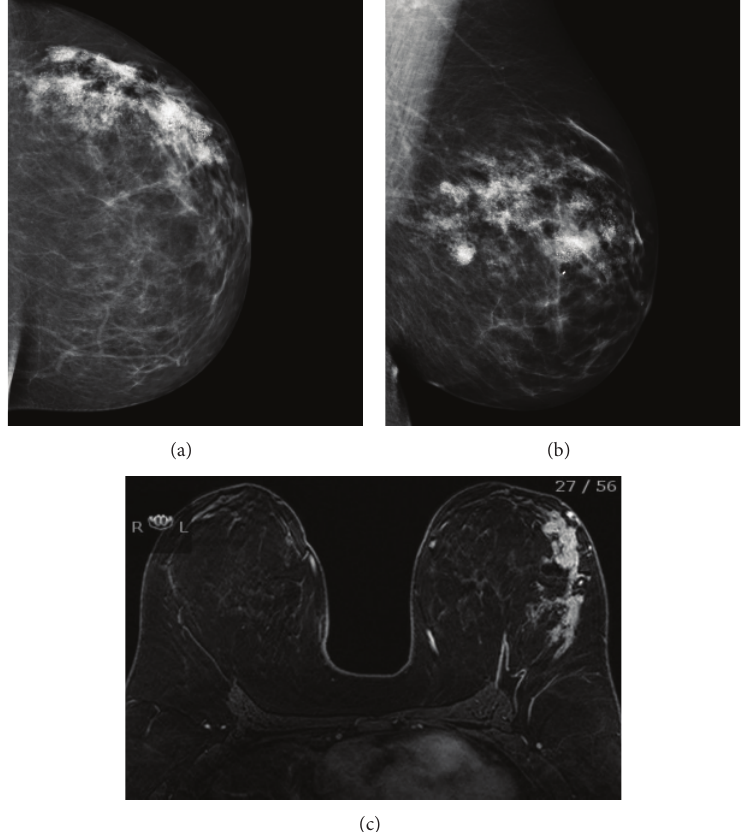
Figure 1: Representative imaging of patient in Case 1. Left mammogram showing clustered calcification corresponding to multiple sites of disease in craniocaudal (a) and mediolateral-oblique (b) projections. MRI showing extensive nonmass enhancement in the lateral hemisphere of the left breast in segmental distribution (c).